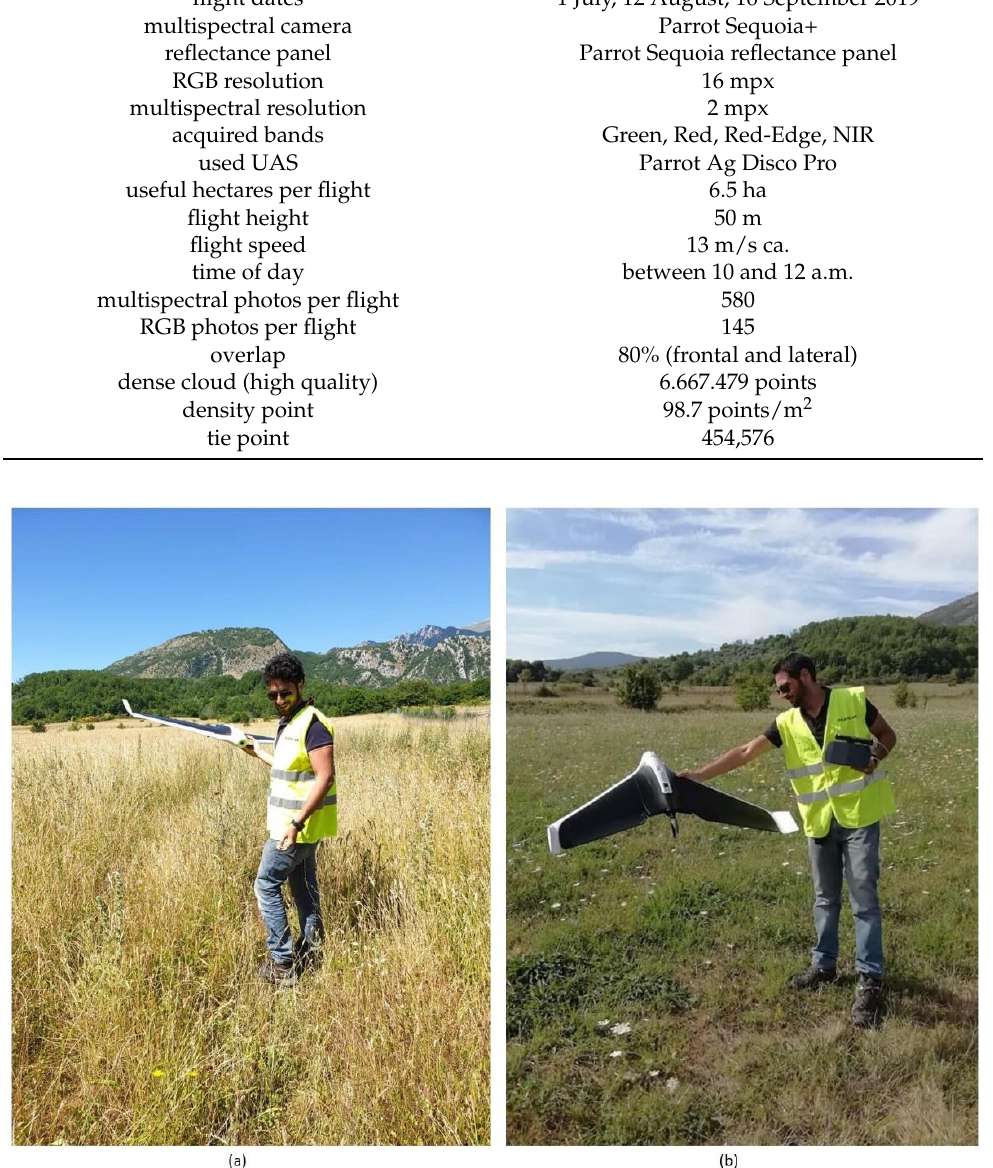
Figure 4. Images acquired during the survey activities. The operator is working on ( a ) compass calibration and ( b ) take-off. ( a ) 1 July 2019; ( b ) 16 September 2019.